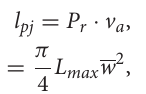
a full turn. Figure 7B shows the relationship between the twist pitch of jets and the volume of jets. The twist pitch ( l pj ) and volume ( V ) of a jet are defined